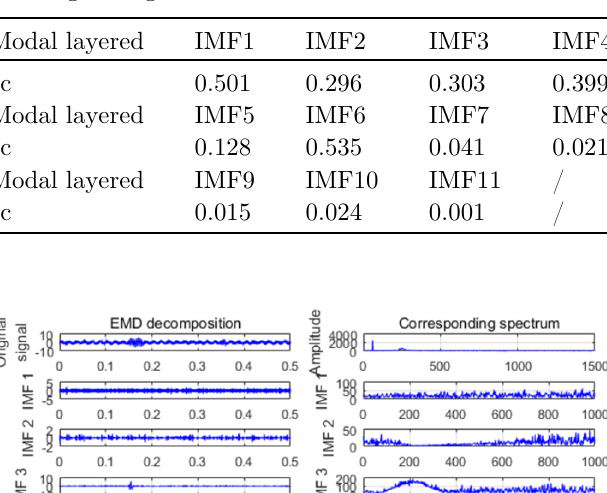
Table 2. Performance comparison under different input signal-to-noise ratios.